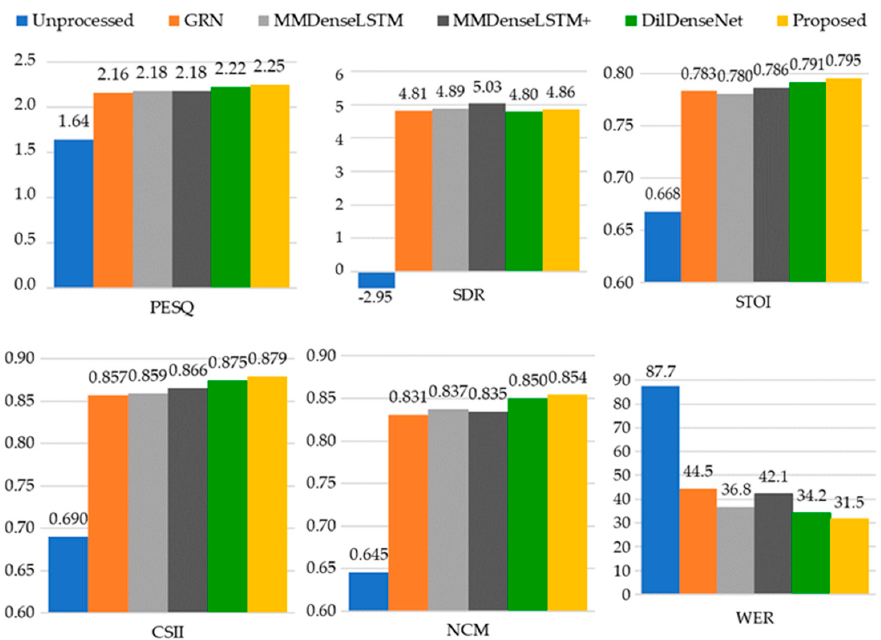
Figure 5. Comparison of perceptual evaluation of speech quality (PESQ), signal-to-distortion ratio (SDR), short-time objective intelligibility (STOI), coherence-based speech intelligibility index (CSII), normalized-covariance measure (NCM), and word error rate (WER) results when the music and noise are mixed at 0 dB. PESQ, SDR, STOI, CSII, and NCM are calculated using average statistics. PESQ ranges from − 0.5 to 4.5, STOI, NCM, and CSII range from 0 to 1, and SDR has no fixed range. Larger values of the performance evaluation indicators represent better performance.